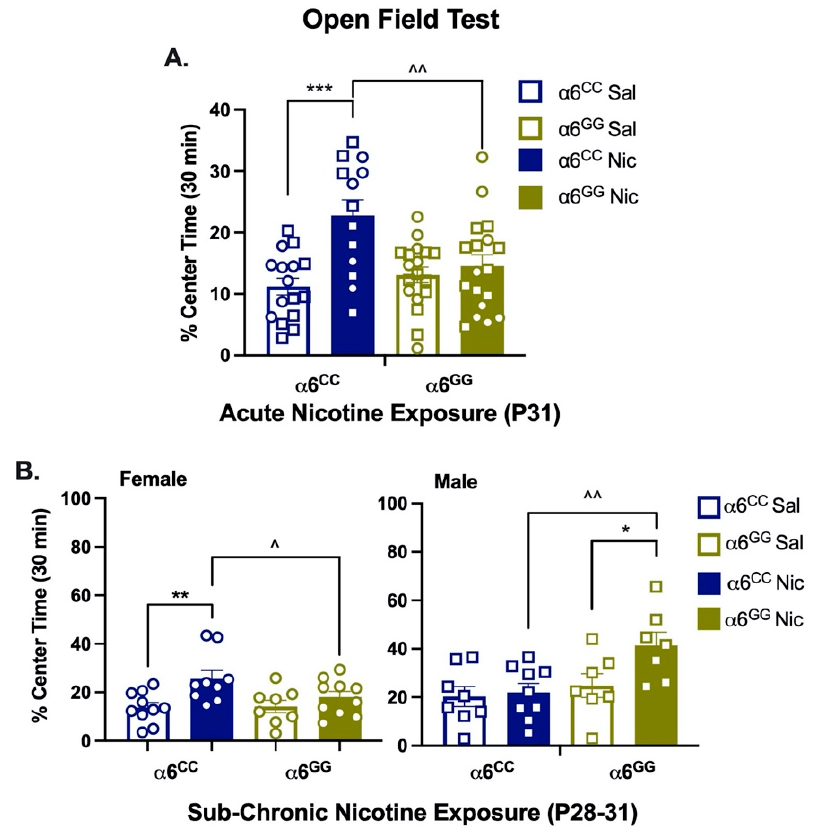
Figure 4. Nicotine-induced anxiolytic behavior in humanized CHRNA 6 3 ′ -UTR SNP rats. Mean percent (%) time spent in center ± SEM for ( A ) acute (1-day) nicotine exposure *** p < 0.001 α 6 CC Nic vs α 6 CC Sal, ˆˆ p = 0.01 α 6 CC Nic vs α 6 GG Nic n = 13–18/group. ( B ) Sub-chronic (4-day) nicotine exposure, * p < 0.05, ** p < 0.01 Nic vs Sal; ˆ p < 0.05, ˆˆ p < 0.01 α 6 CC Nic vs α 6 GG Nic, n = 7–10/group. Saline (Sal), Nicotine (Nic). Circles represent females, and squares represent males.